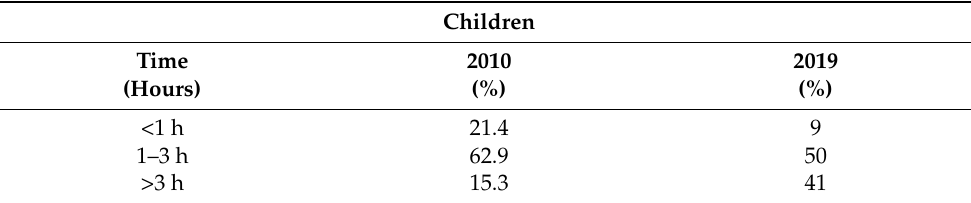
Table 4. Comparison of hours of MD usage in 2010 and 2019 in